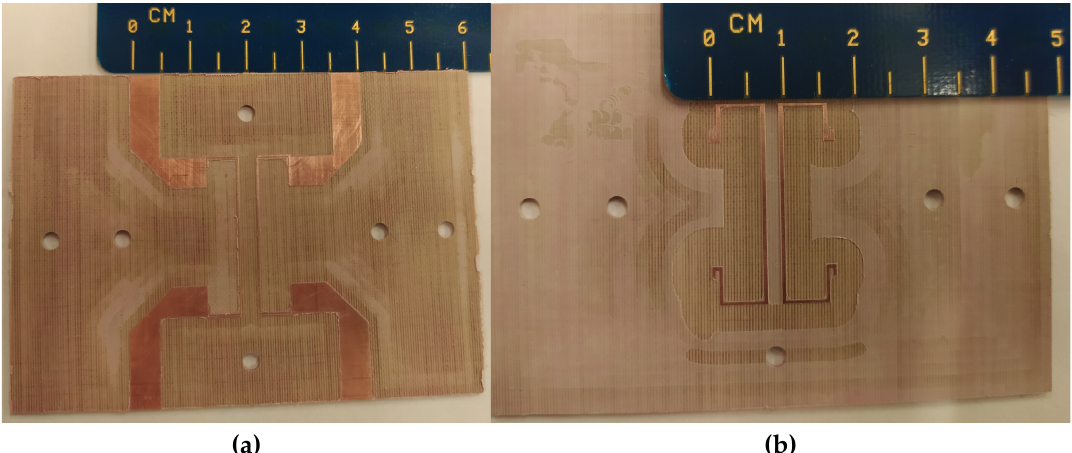
Figure 8. Photograph of the manufactured prototype: ( a ) Top layer; ( b ) middle layer.